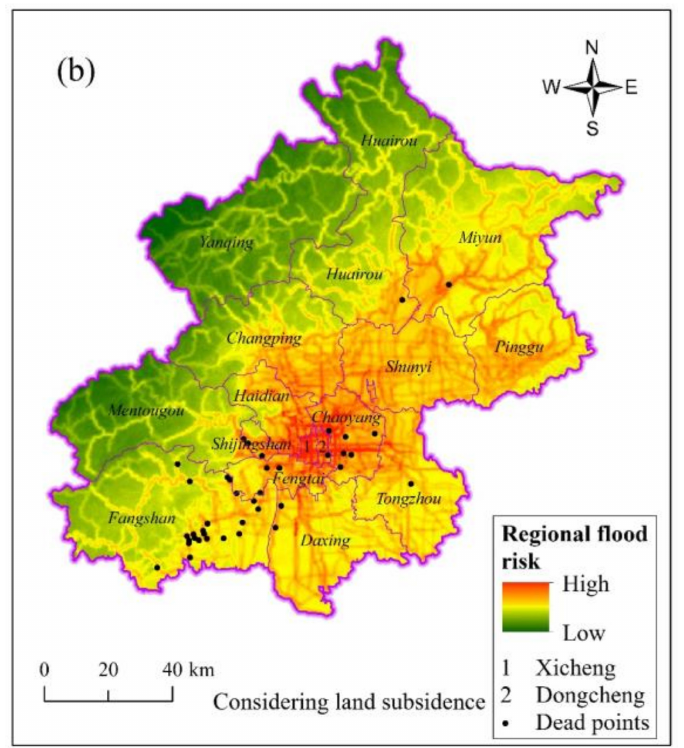
Figure 12. Regional flood risk level map of Beijing. Dead points were derived from the historical flood event on 21 July 2012. ( a ) Ignoring land subsidence; ( b ) Considering land